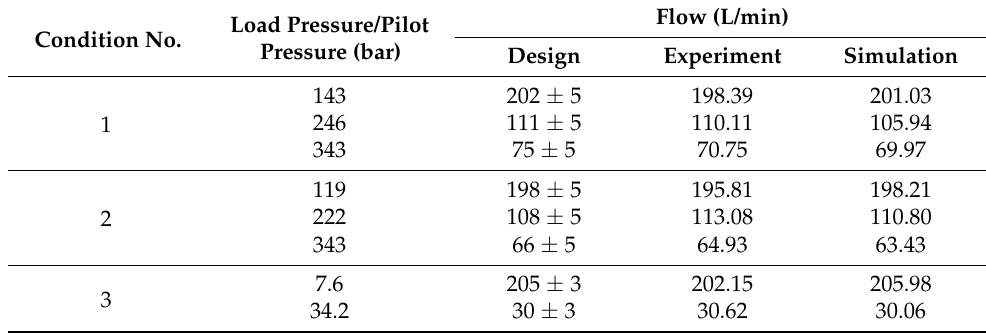
Table 4. Design value, test value, and simulation value of characteristic flow points.